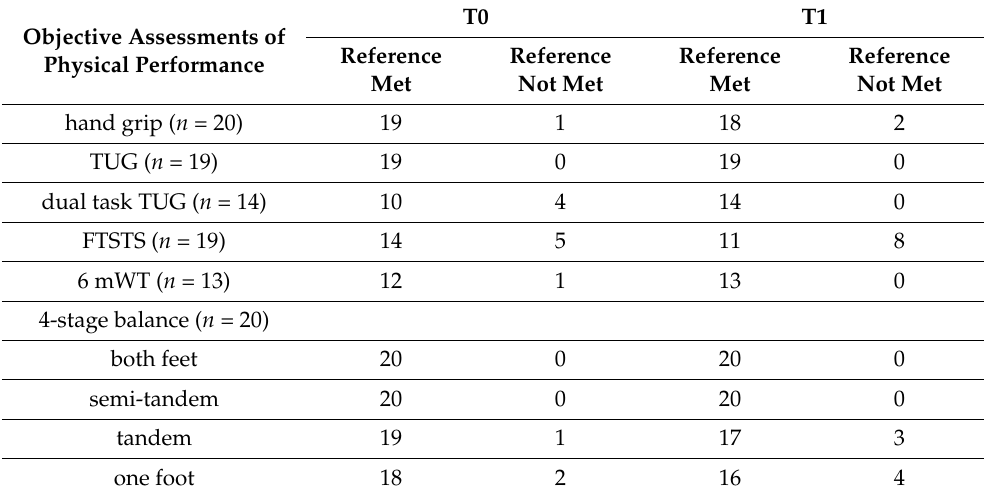
Table 2. Objective assessments of physical performance of participants with available data for baseline (T0) and post-assessments (T1) categorized according to reference values.